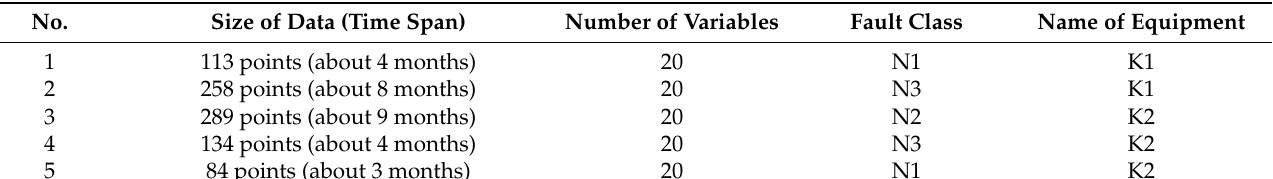
Table 1. The details of robot arm data.